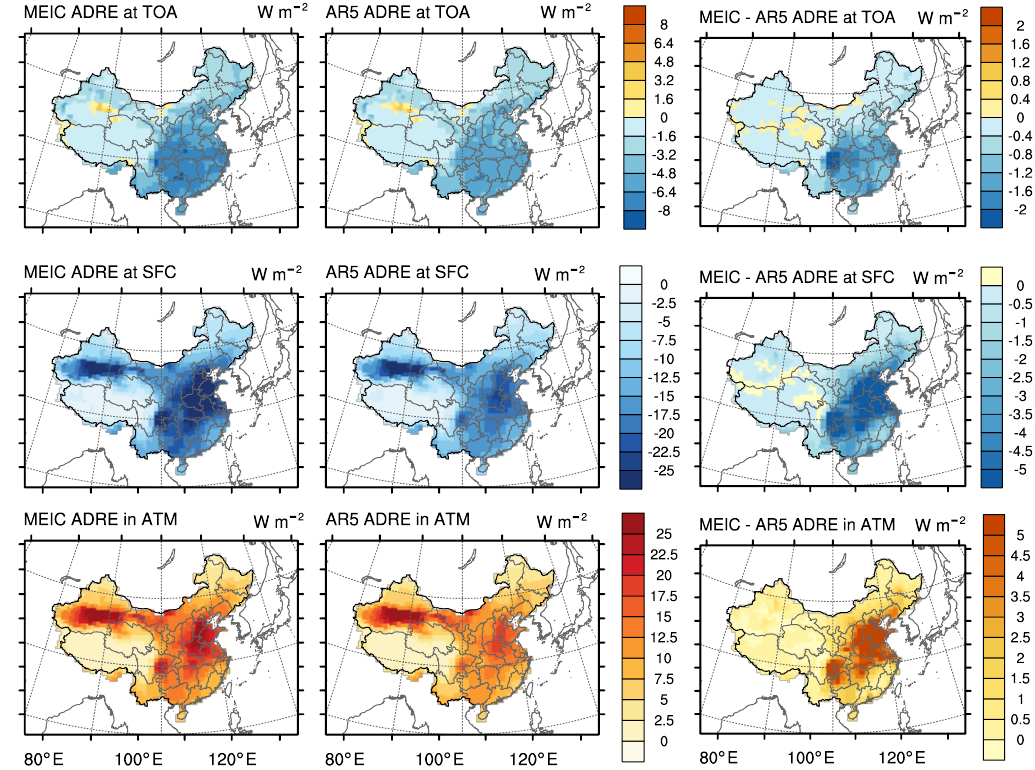
Figure 12. Spatial distributions of the annual-average aerosol direct radiative effects (ADREs) at TOA, at the surface (SFC), and in the atmosphere (ATM) using the MEIC and the AR5 emissions and their differences in year